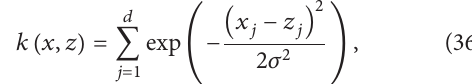
00.511.52 −2−1.5−1−0.5 KSIR variates for the first nonlinear e.d.r. direction Figure 1: Dimension reduction for model (35): (a) mean square error for RKSIR with different regularization parameters; (b) mean square error for various dimension reduction methods. The blue line represents the mean square error without using dimension reduction. (c)-(d) RKSIR variates versus nonlinear